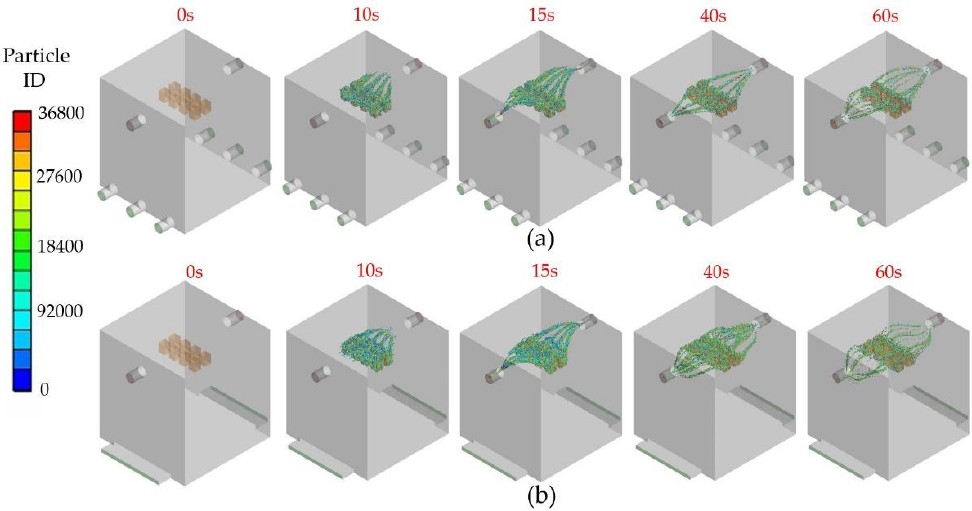
Figure 9. Particle traces of Cr 2 O 3 for ( a ) circular inlet and ( b ) rectangular inlet.